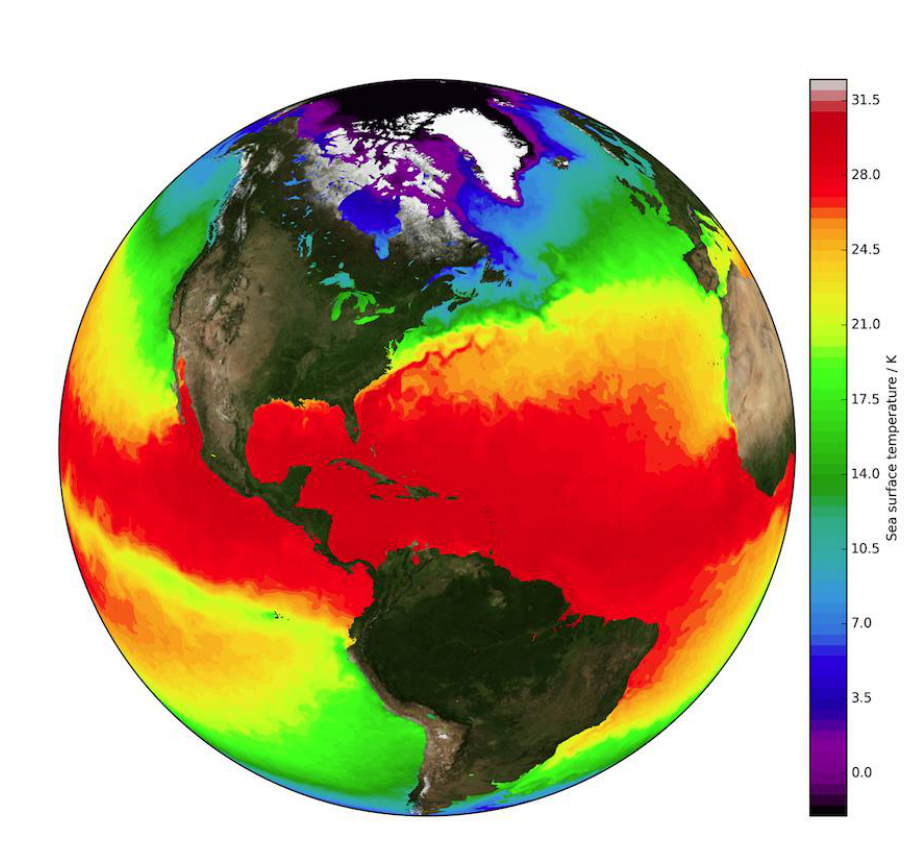
Figure 1. Global Sea Surface Temperature (SST) during La Nina (October 1998). Globally complete analysis of SST, synthesized from infra-red observations made by meteorological and research satellites. The analysis is a 0.05 deg resolution in latitude and longitude and is daily. See